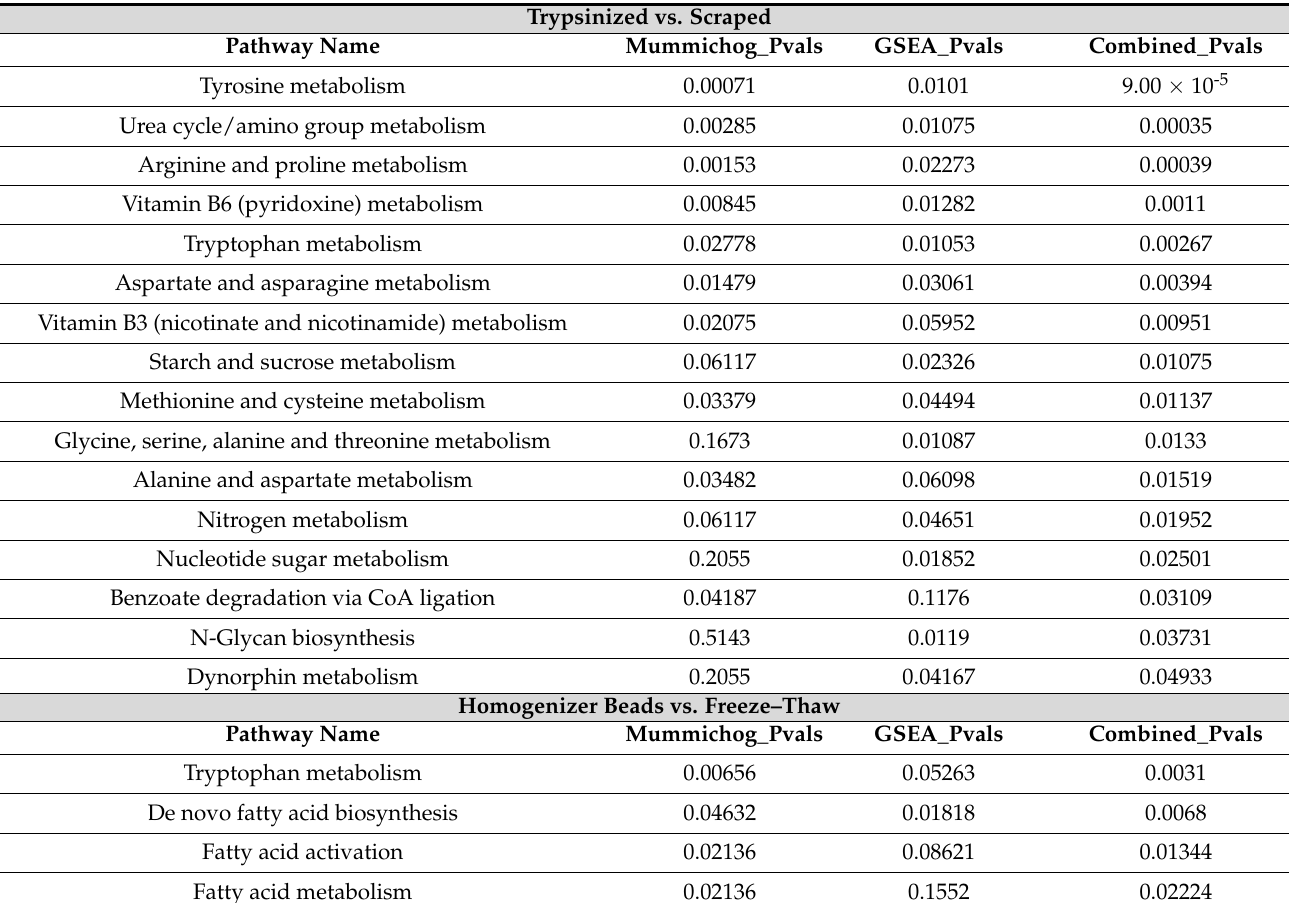
Table 1. Significance values of the perturbed pathways due to detachment and lysis methods. Trypsinized vs.